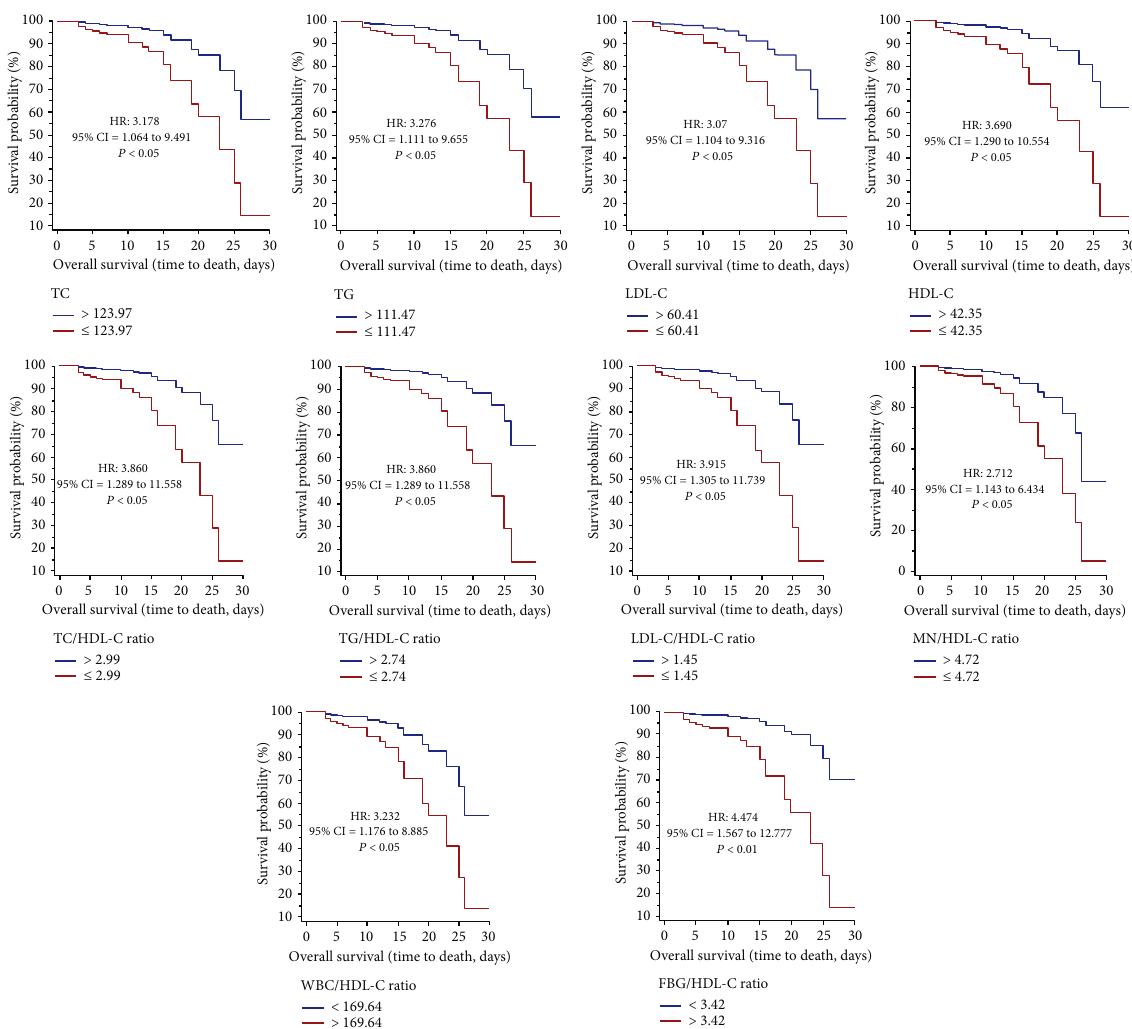
Figure 3: The Kaplan – Meier survival curves during hospitalization of COVID-19 patients with di ff erent cut-o ff values of the lipid pro fi le ratios investigated. FBG: fasting blood glucose; HDL-C: high-density lipoprotein-cholesterol; LDL-C: low-density lipoprotein-cholesterol; LM: lymphocyte; MN: monocyte; TC: total cholesterol; TG: triglyceride; WBC: white blood